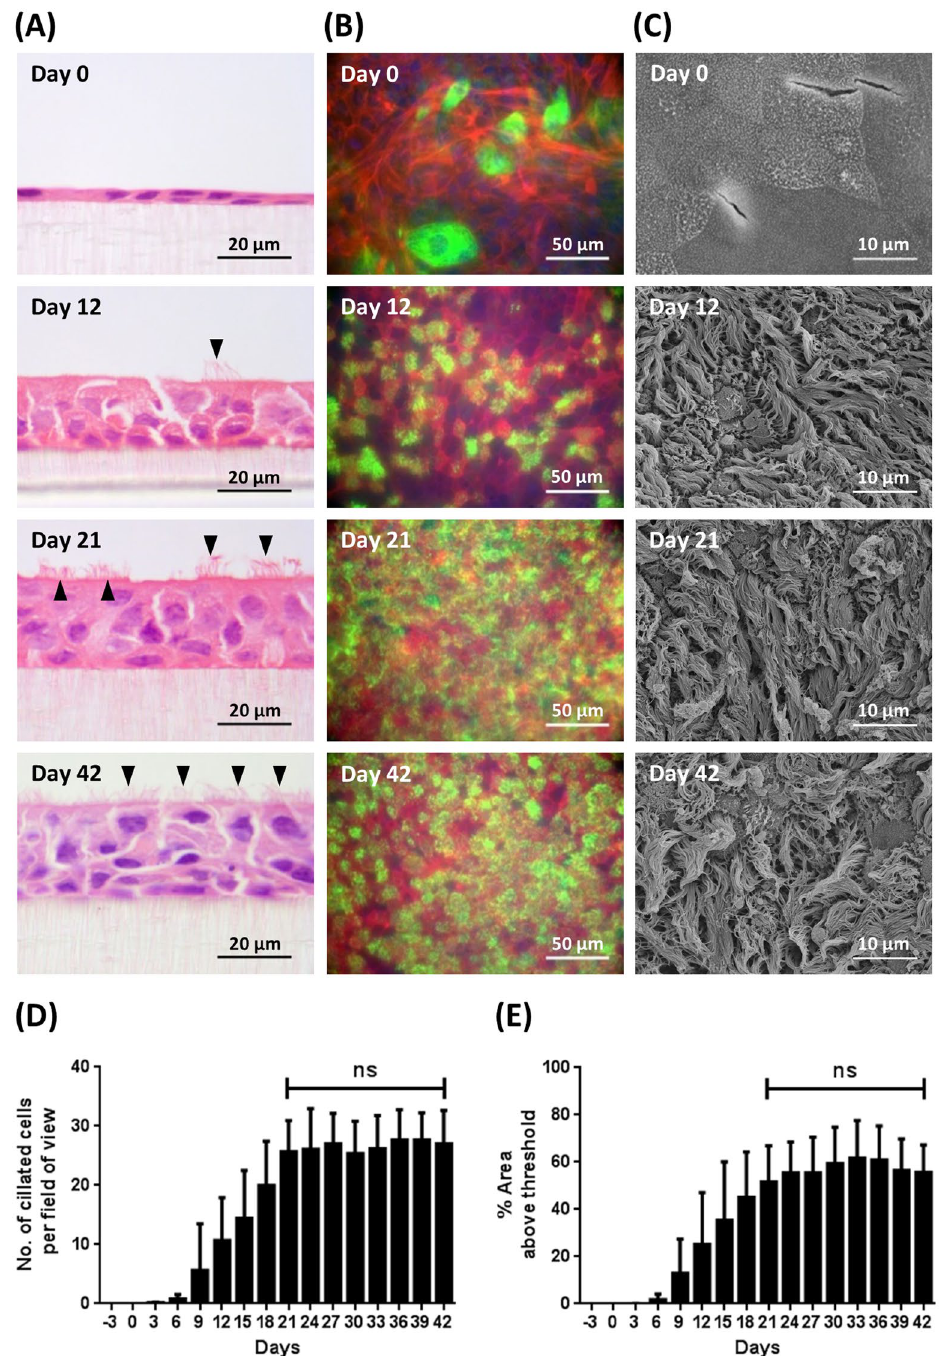
Figure 4. Cilia formation in BBEC cultures over time. Bronchial epithelial cell cultures were grown for the indicated number of days at an ALI (relative to the establishment of the ALI) before fixation. The BBEC cultures were subsequently processed to assess ciliation using ( A ) H&E staining of histological sections (arrowheads indicate ciliated cells), ( B ) immunofluorescence staining (cilia - green; F-actin - red; nuclei - blue) and ( C ) SEM. Representative images are shown of BBECs grown for 0, 12, 21 and 41 days post-ALI (see also Figs S1, S5 and S6). Quantitative analysis (using ImageJ) of ciliation of BBEC cultures fixed at three-day intervals ranging from day − 3 to day 42 post-ALI was performed ( D ) by counting the number of ciliated cells per field of view in H&E-stained sections (see Fig. S1) and ( E ) using fluorescence intensity thresholding of immunostained cultures (see Fig. S5). In ( D ) for each insert, ciliated cells were counted in each of five randomised 400x fields of view evenly distributed across the strand. In ( E ) ciliation was quantified by measuring the area above a fluorescence intensity threshold in ImageJ; for each insert, five regions evenly distributed across the sample were measured. For all of the above quantifications, three inserts were analysed per time-point and the data represents the mean + / − standard deviation from tissue derived from three different animals (n = 9). Statistical significance was tested using an Ordinary one-way ANOVA: ns = not